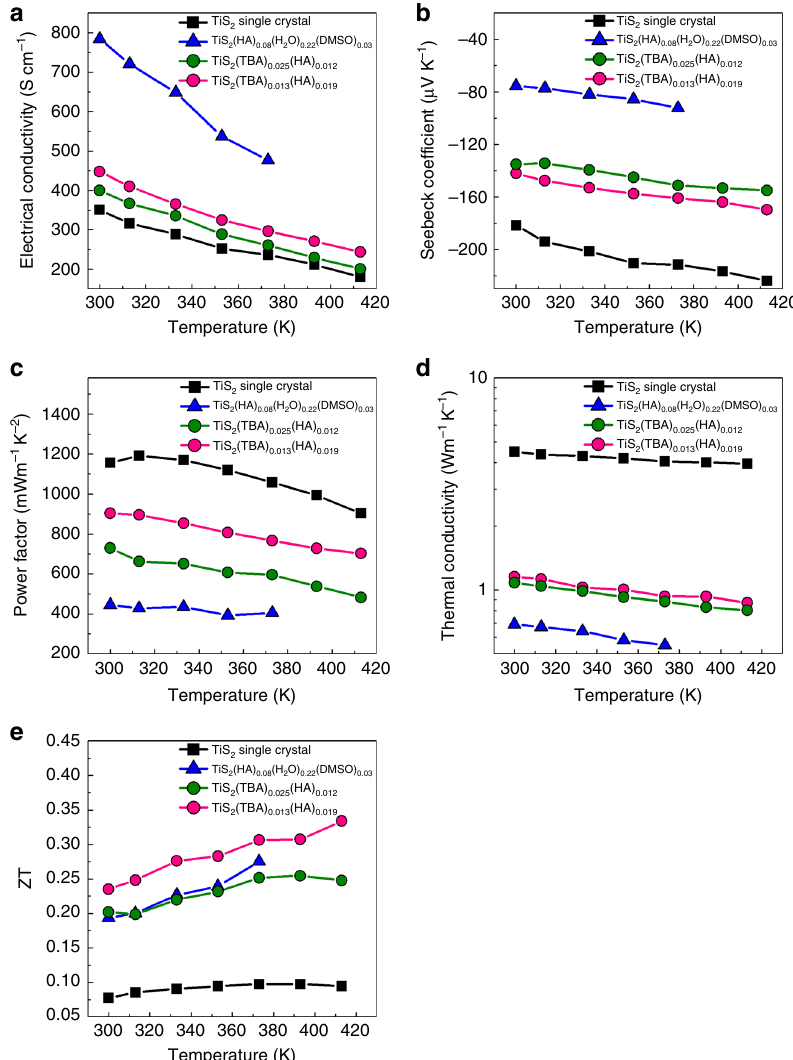
Fig. 4 In-plane thermoelectric properties of TiS 2 (TBA) 0.025 (HA) 0.012 , TiS 2 (TBA) 0.013 (HA) 0.019 compared with TiS 2 single crystal and TiS 2 (HA) 0.08 (H 2 O) 0.22 (DMSO) 0.03 : a in-plane electrical conductivity, b in-plane Seebeck coef fi cient, c in-plane power factor, d in-plane